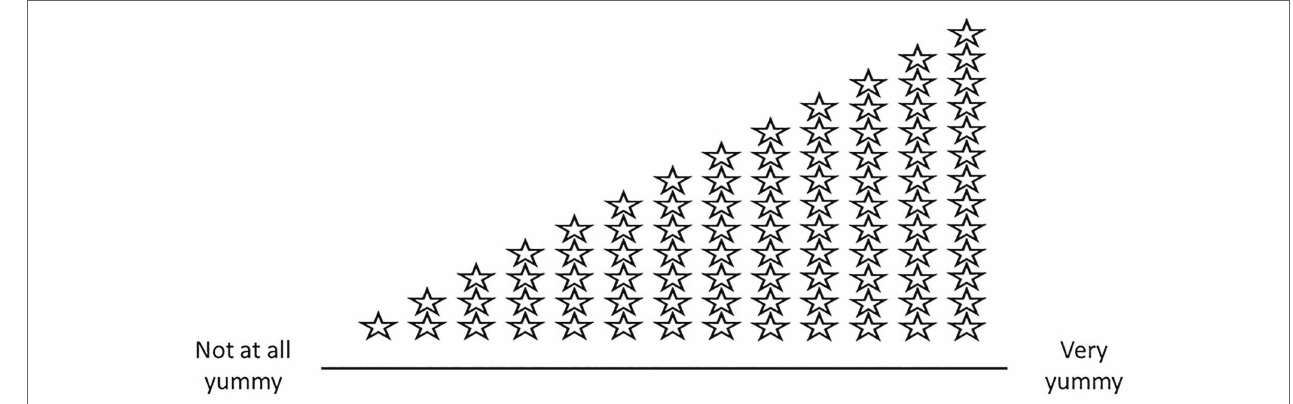
FIGURE 3 | Visual analogue scale used to rate